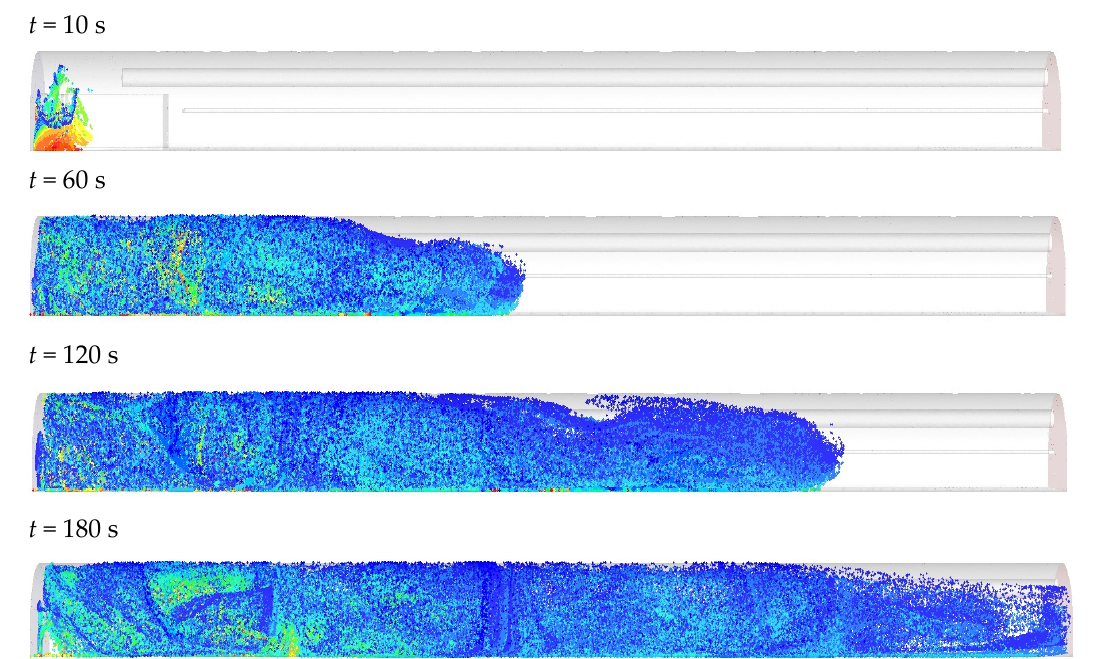
Figure 5. Distribution of different-sized dust particles in the dog heading at various time points for total dust rate = 0.00125 kg/s.